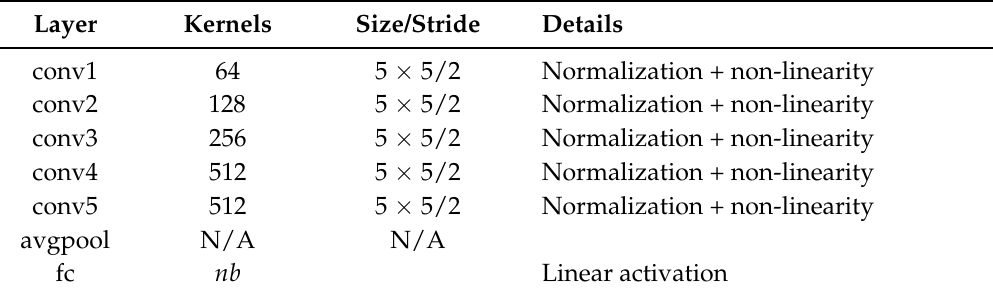
Table 1. A tabular representation of the SimpleNet layers’ specifications.